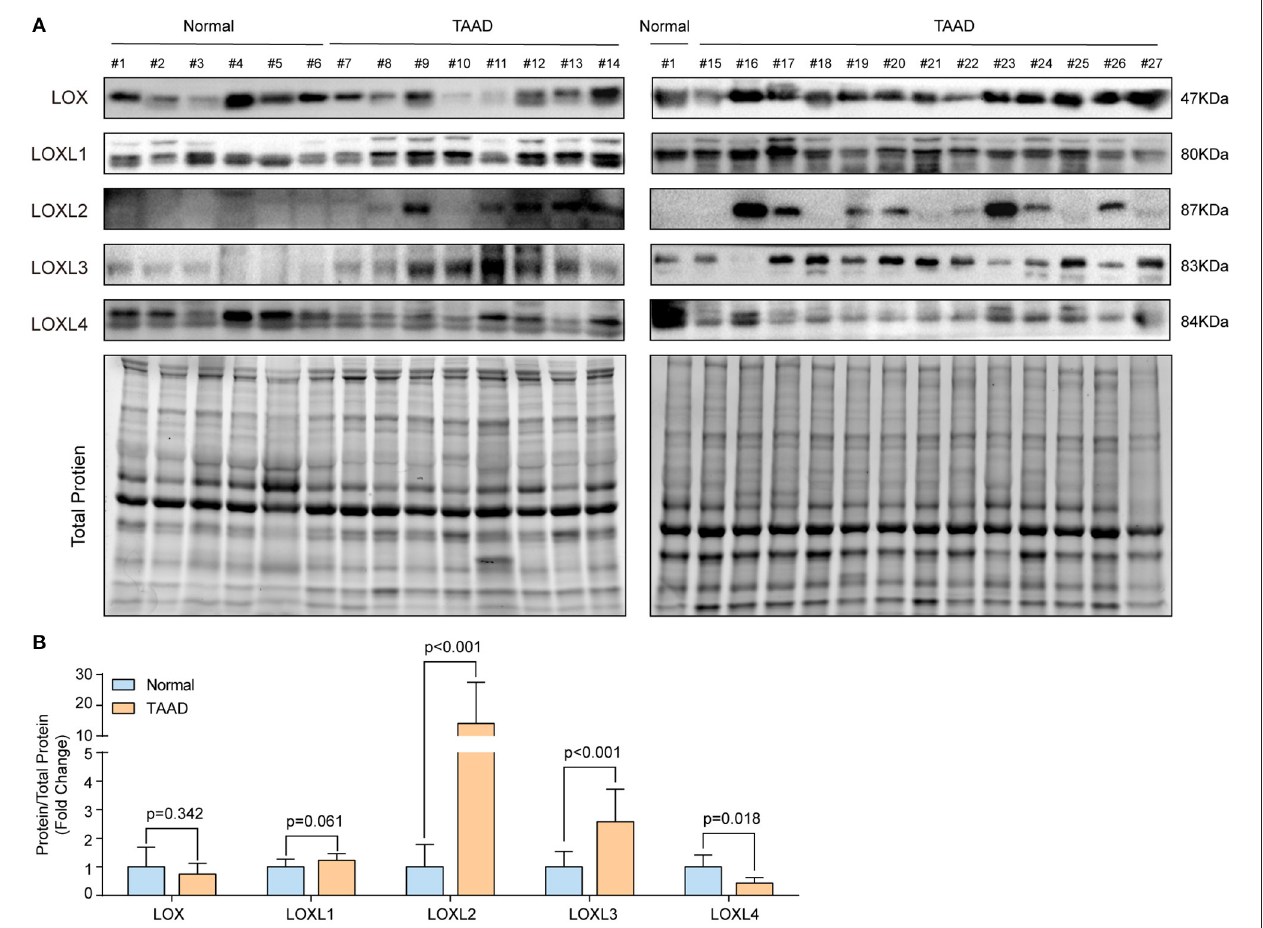
FIGURE 2 | The protein levels of LOXs in the human aorta. (A) The protein levels of LOXs were detected in aorta samples from 6 normal controls and 21 TAAD patients by using western blotting. (B) Relative quantification of LOXs protein levels in (A) . Total protein served as the loading control.